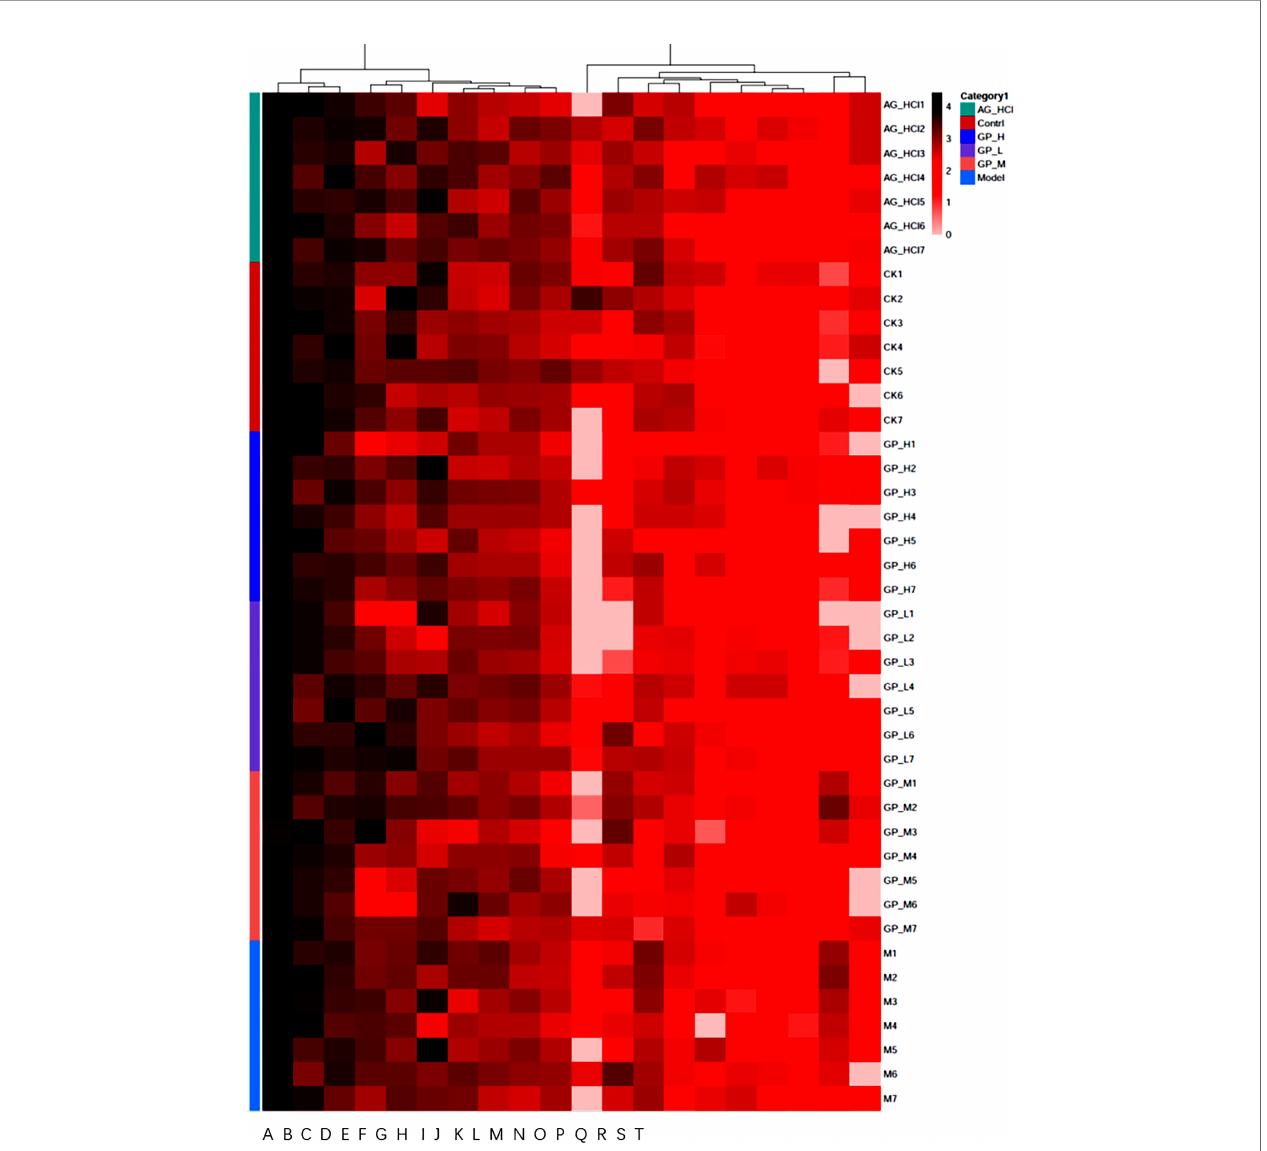
FIGURE 7 | The heatmap on genus (A) Unspeci fi ed_S24_7; (B) Lactobacillus; (C) Unspeci fi ed_Clostridiales; (D) Streptococcus; (E) Turicibacter; (F) Unspeci fi ed _Lachnospiraceae; (G) Unspeci fi ed_Rikenellaceae; (H) Bacteroides; (I) Ruminococcus; (J) Oscillospira; (K) Roseburia; (L) Bi fi dobacterium; (M) Coprococcus); (N) Adlercreutzia; (O) Ruminococcus; (P) Parabacteroides; (Q) Unspeci fi ed_Ruminococcaceae; (R) Unspeci fi ed_Mogibacteriaceae; (S) Unspeci fi ed_Clostridiaceae; (T) Unspeci fi